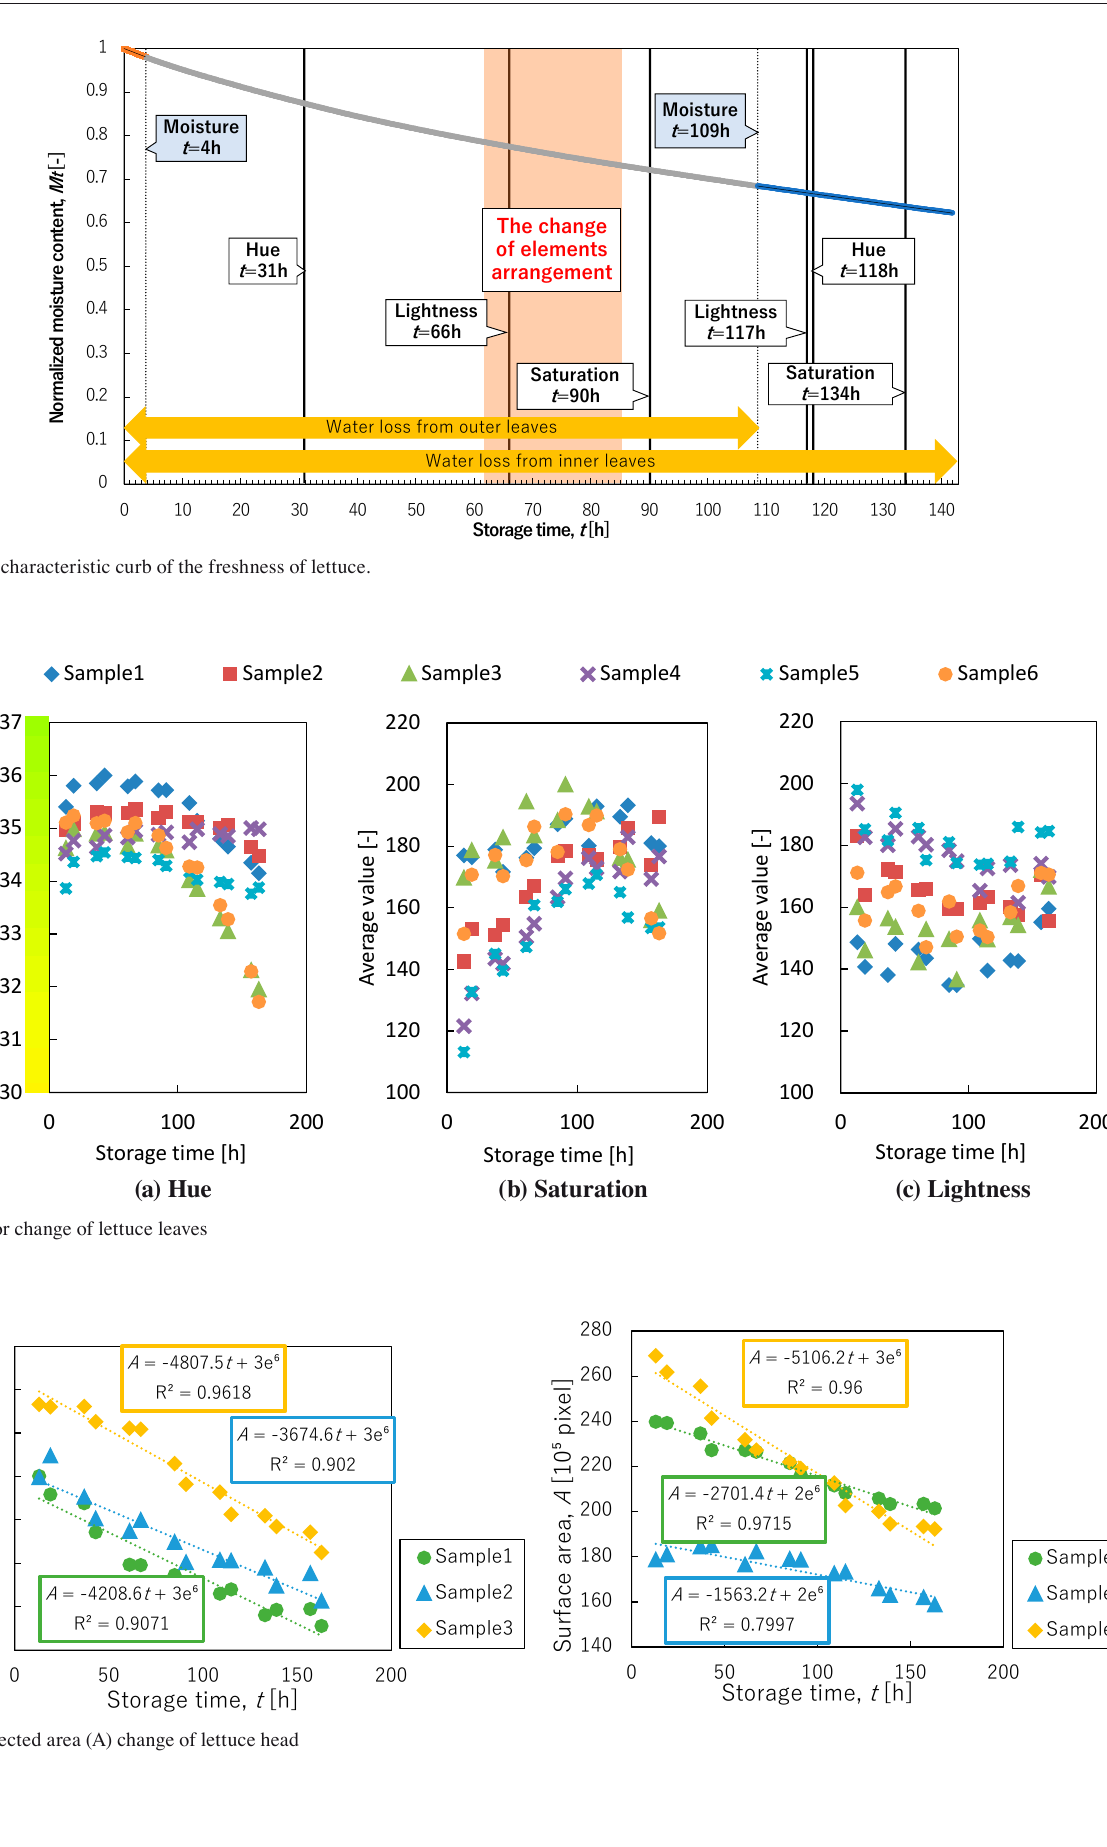
FFiigg.. 1144 MMaaccrroonnuuttrriieennttss ((KK,, CCaa,, PP)) aanndd lliigghhtt eelleemmeenntt ((LLEE)) cchhaannggee dduurriinngg 713